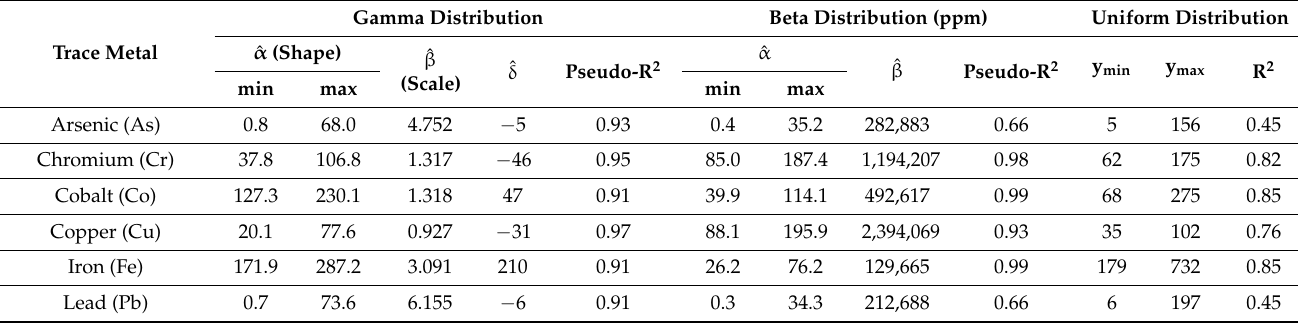
Table A3. Selected descriptive statistics for the theoretical analytical error of the 15 trace metals measured via Syracuse soil sample assaying ( n = 3324 soil sample points).